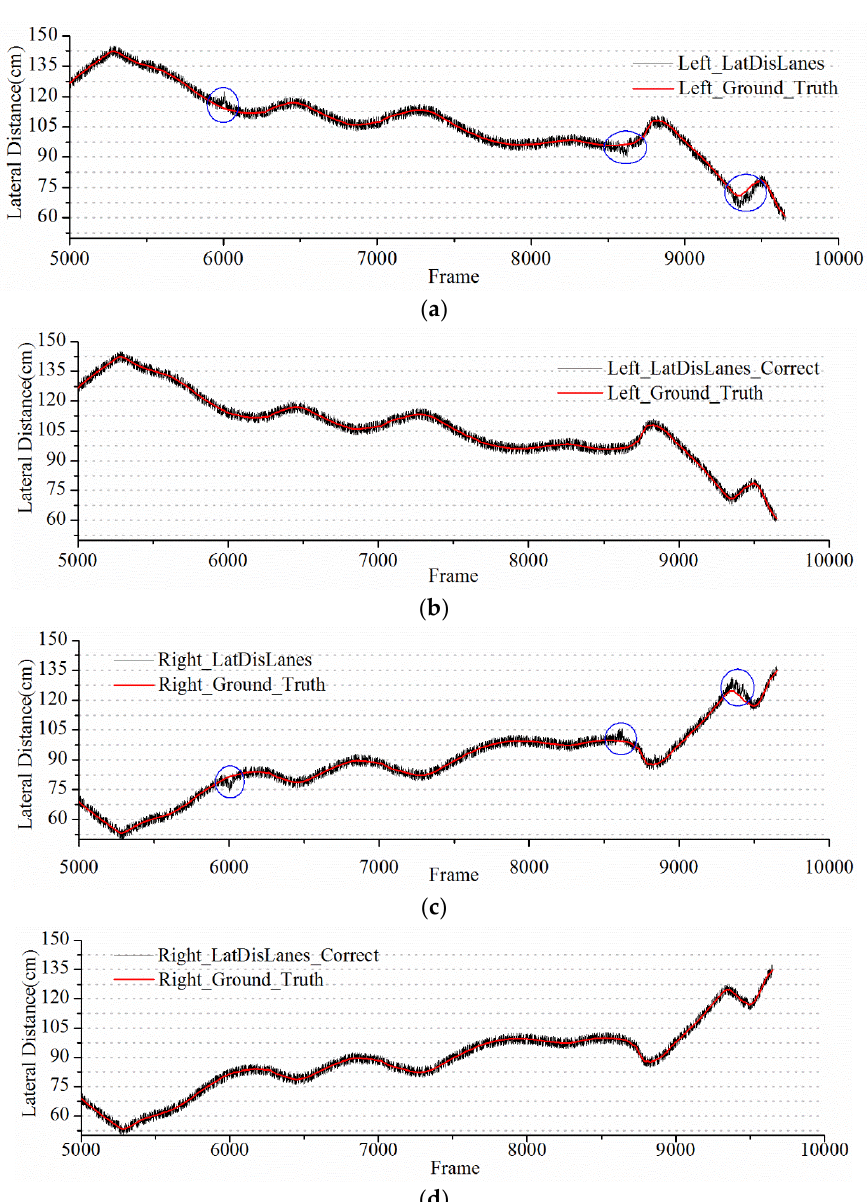
Figure 13. The red line is the ground truth. The black in ( a , b ) is the output of DisLanes, wherein the black line away from the red that means larger error in the circle. The black line fluctuates in a small range compared to the red after the correct model in ( c , d ).